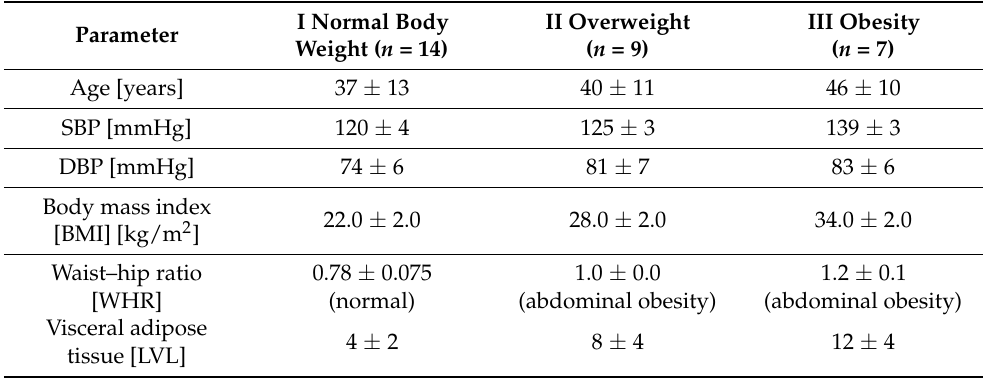
Table 2. Characteristics of the anthropometric parameters of patients with normal body weight, overweight and obesity. Data are presented as mean values and their standard deviations.